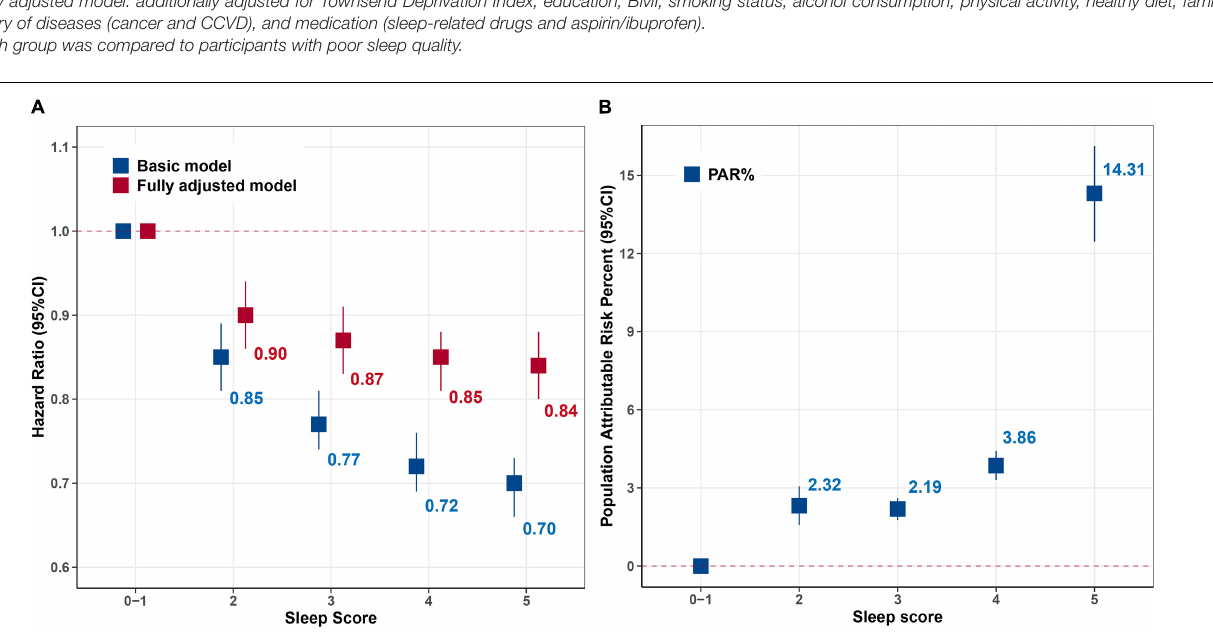
FIGURE 1 | Hazard ratio (HR) and population attributable risk percentage (PAR%) for risk of terminated health span according to sleep score. (A) HR [95% confidence interval (95% CI)]. (B) Population attributable risk percentage (PAR%). Basic model: adjusted for age, sex, and ethnicity. Fully adjusted model further adjusted for Townsend Deprivation Index, education, body mass index (BMI), smoking status, alcohol consumption, physical activity, healthy diet, family history of diseases [cancer and cardiac–cerebrovascular disease (CCVD)], and medication (sleep-related drugs and aspirin/ibuprofen). Sleep scores 0–1 were the reference. The values were the point estimation of HRs and